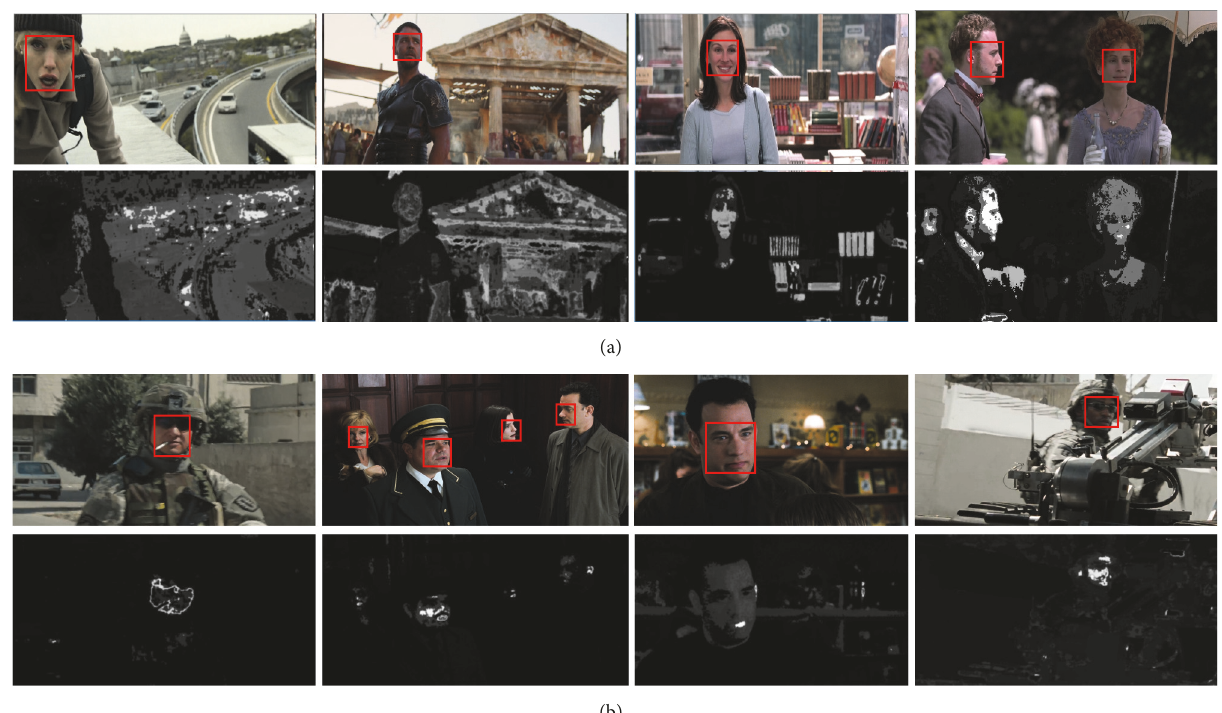
Figure 2: Sample frames from test movies: (a) highly salient shots with detected actor’s faces and saliency maps and (b) low salient shots with detected actor’s faces and saliency